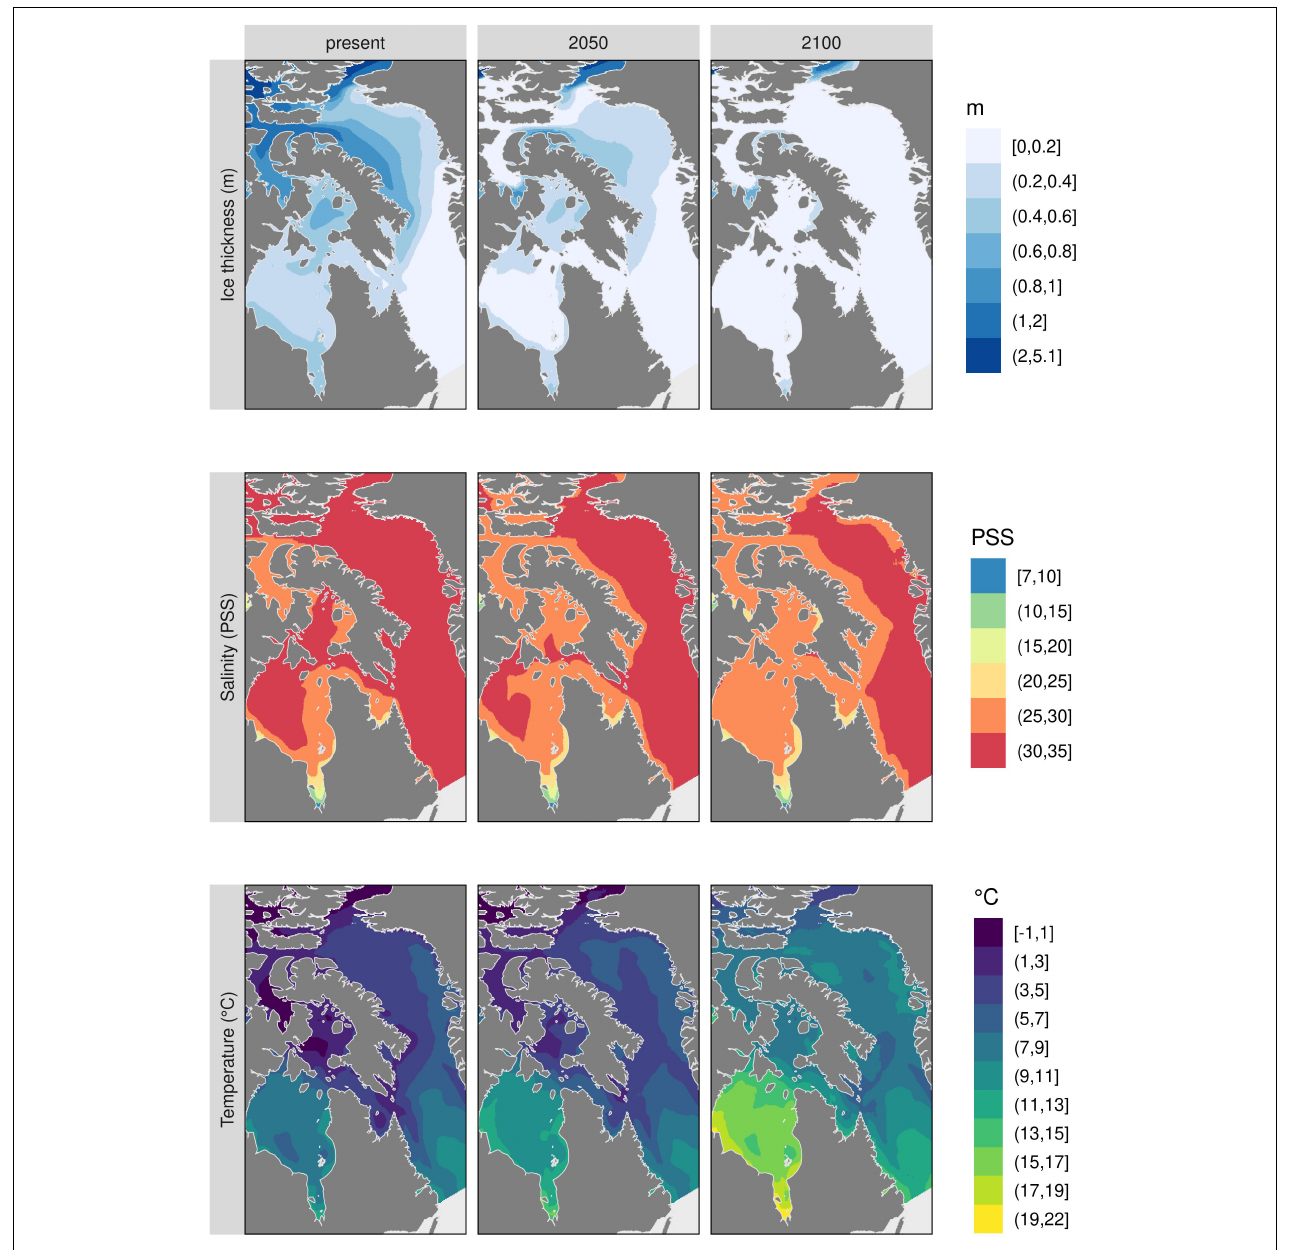
FIGURE 6 | Top three environmental predictors used in kelp models. These layers have been modified from the original source (Bio-ORACLE v2.1; Assis et al., 2018b) to show changes through time in mean ice thickness, mean sea surface salinity, and maximum sea surface